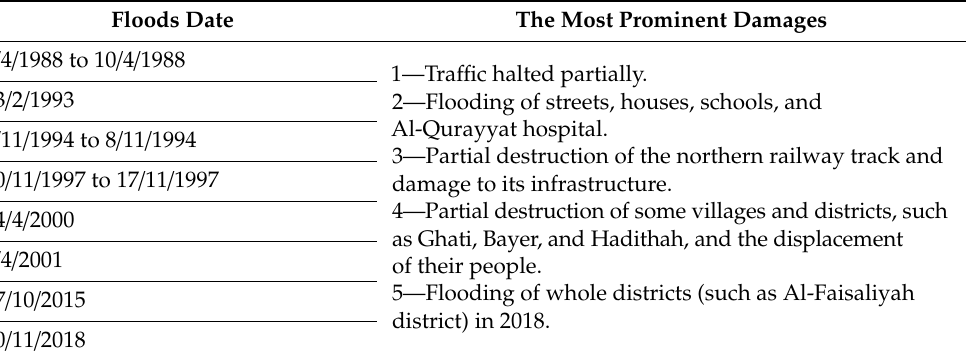
Table 1. Records of historical flood events that occurred in the study area during the period 1988–2018. Floods Date The Most Prominent